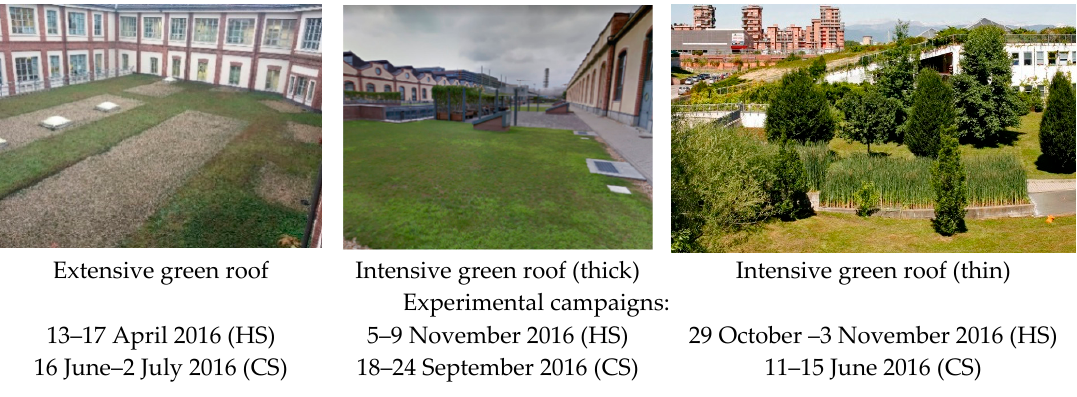
Figure 4. The extensive and intensive green roofs analyzed during the heating (HS) and cooling (CS) seasons.